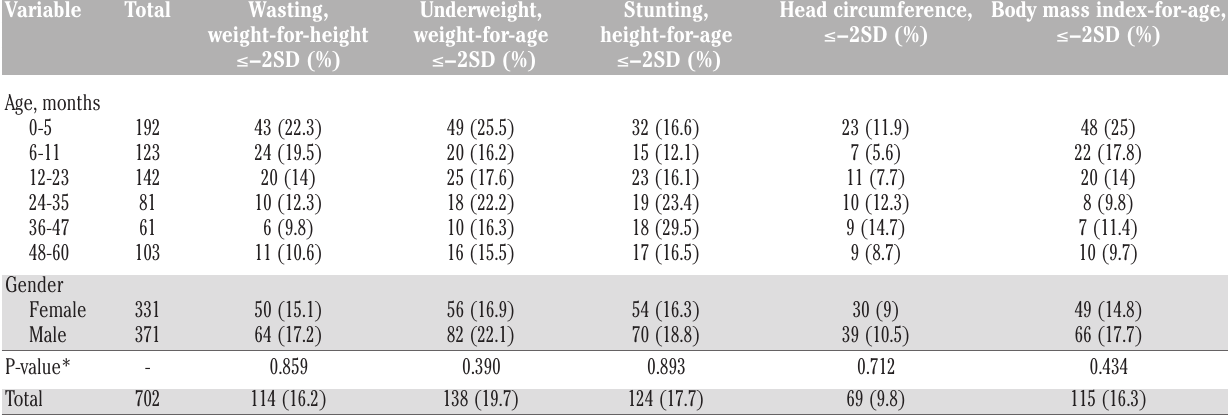
Table 1. Distribution of the children with malnutrition according to age and gender.